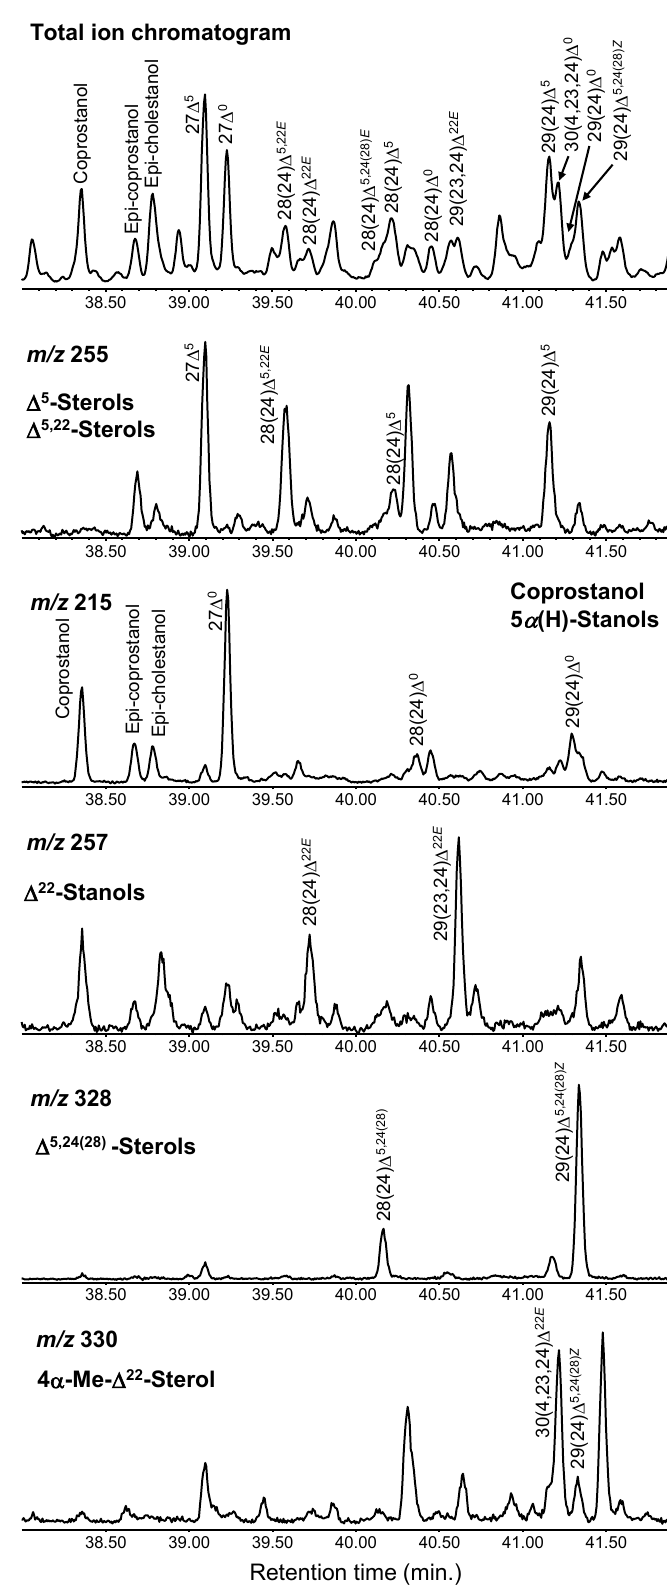
Figure 4. Partial total ion chromatogram and extracted ion chromatograms ( m / z 255, 215, 257, 328, and 330) focused on sterols (38.00–41.88 min) via thermochemolysis using tetramethylammonium hydroxide (TMAH). The symbols are listed in Table